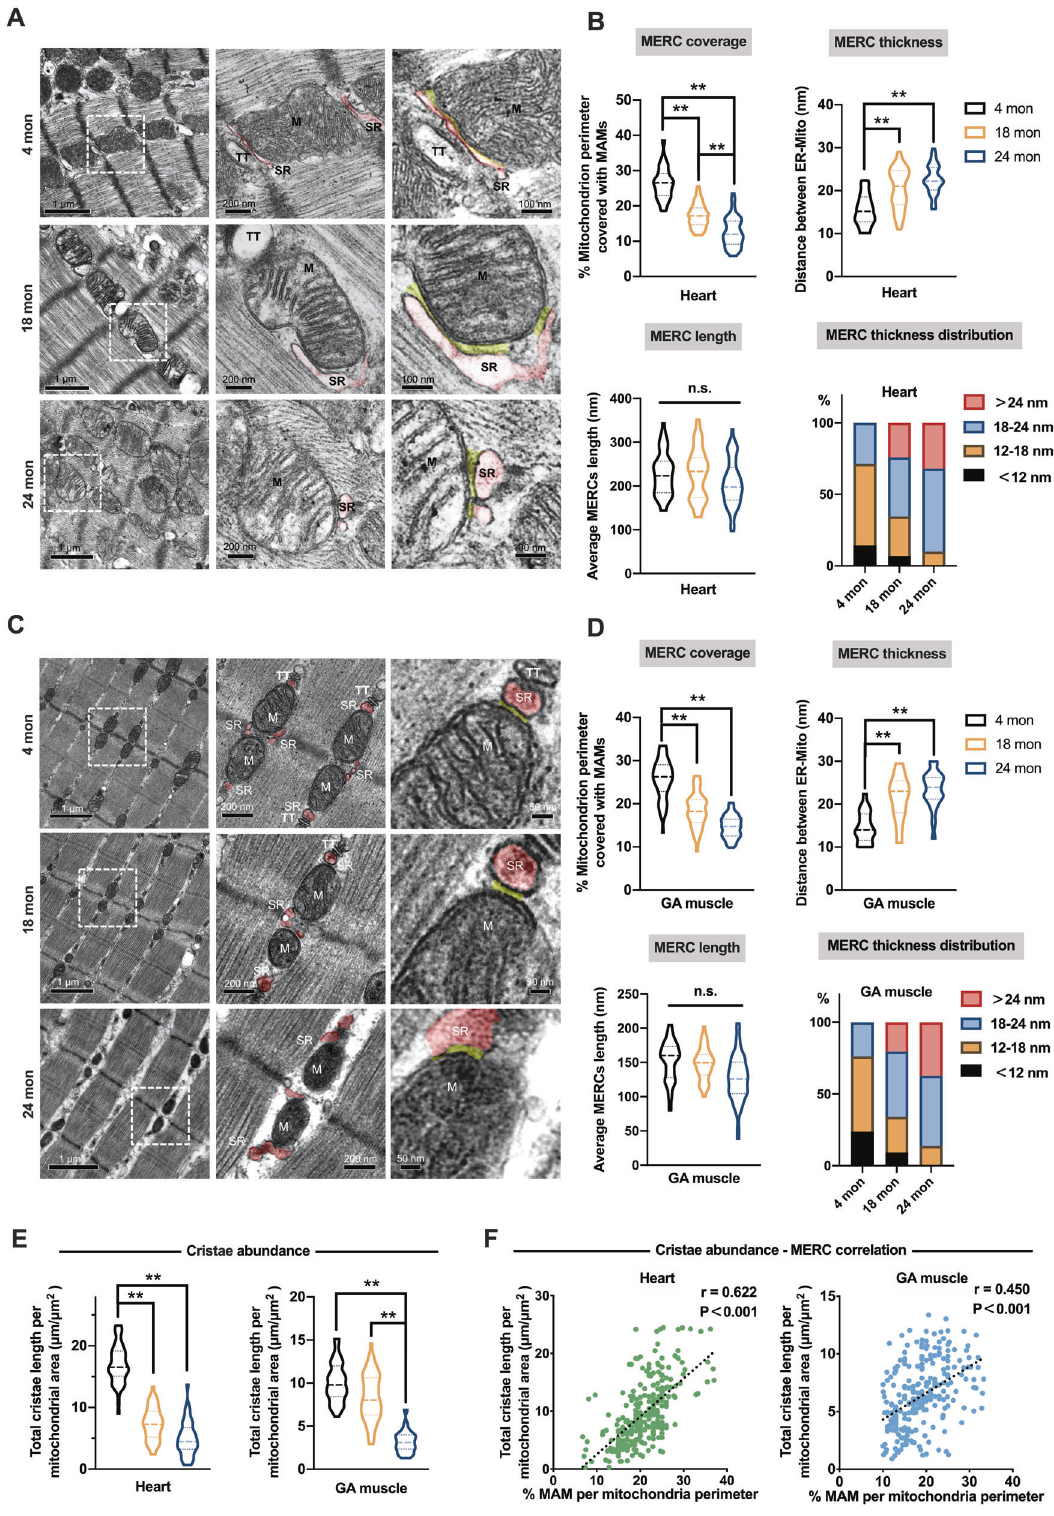
dysfunction, we performed Protein – Protein Interaction